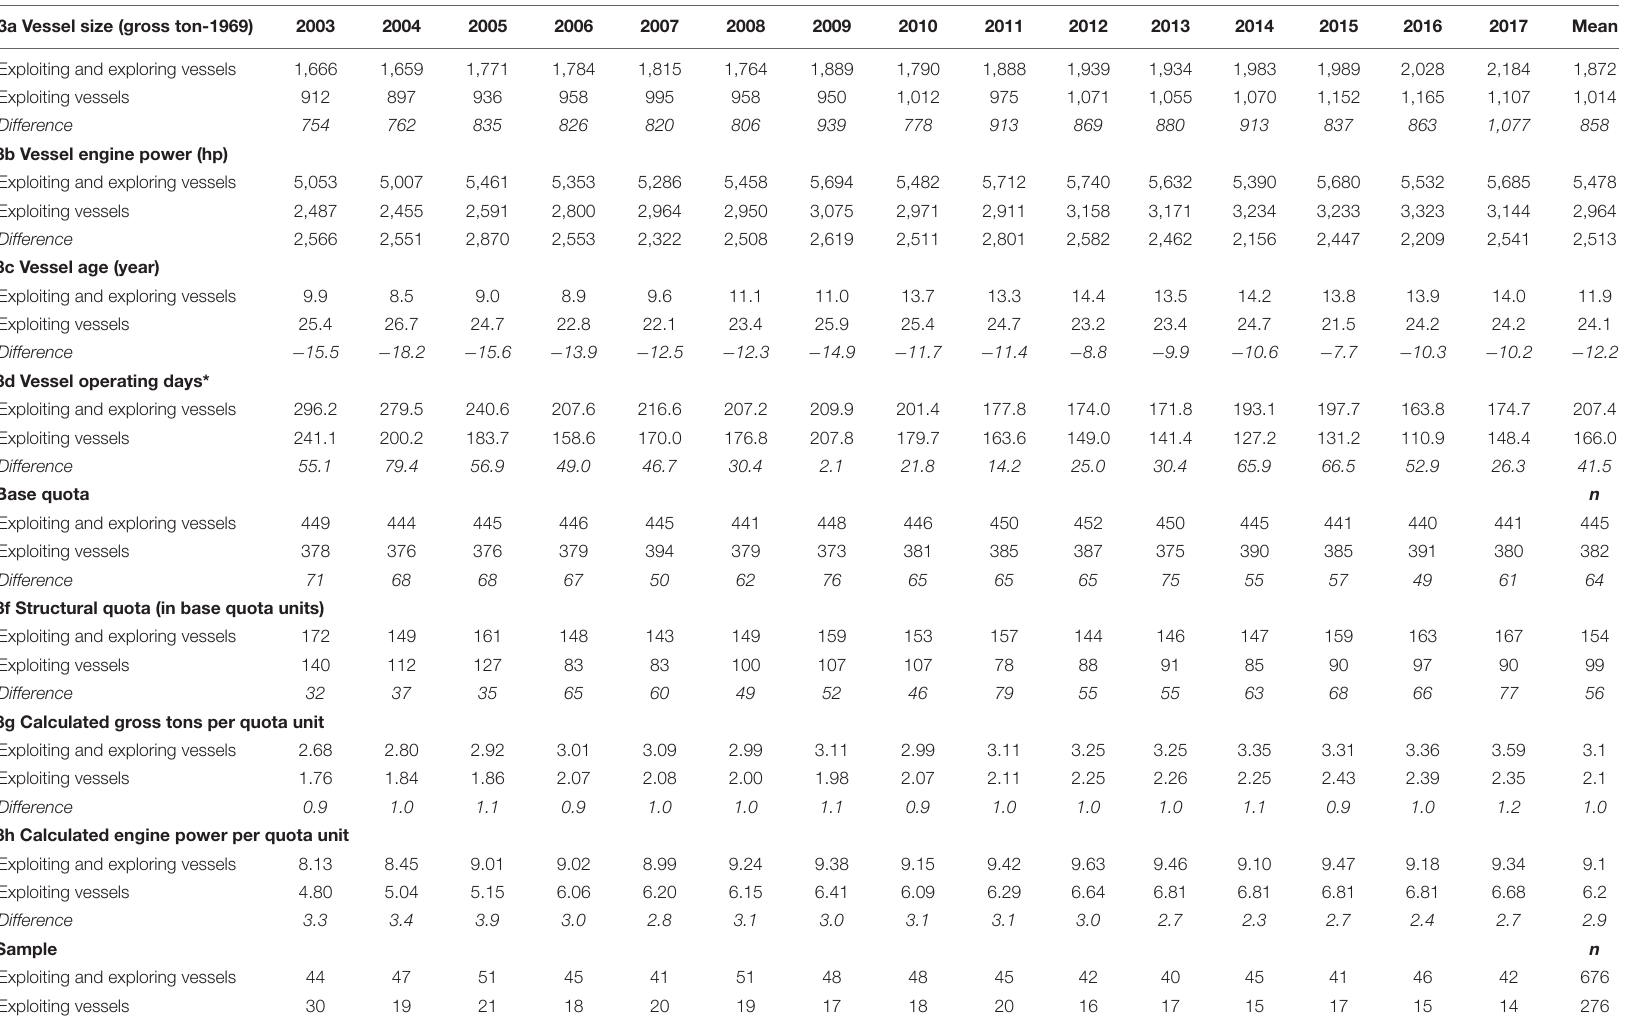
TABLE 3 | Yearly and mean fishing effort of the two vessel